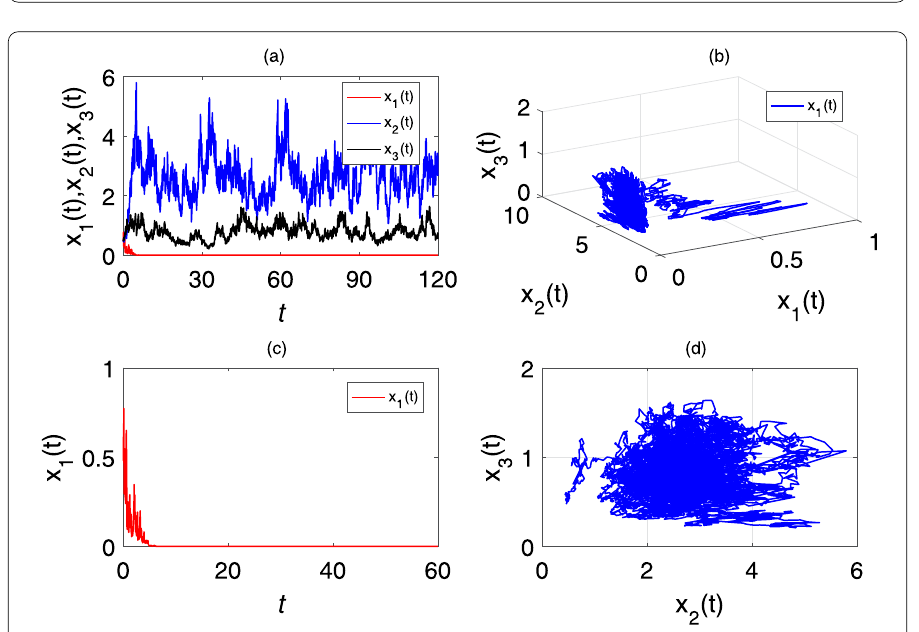
Figure 2 Stochastic permanence of the three population of system (2). (a) is the time sequence diagram and (b) the phase portrait of system (2).( x 1 (0), x 2 (0), x 3 (0)) = (0.5,0.5,0.5), σ 2 1 ( t ) = σ 2 2 ( t ) = σ 2 3 ( t ) = 0.1 + 0.04sin t